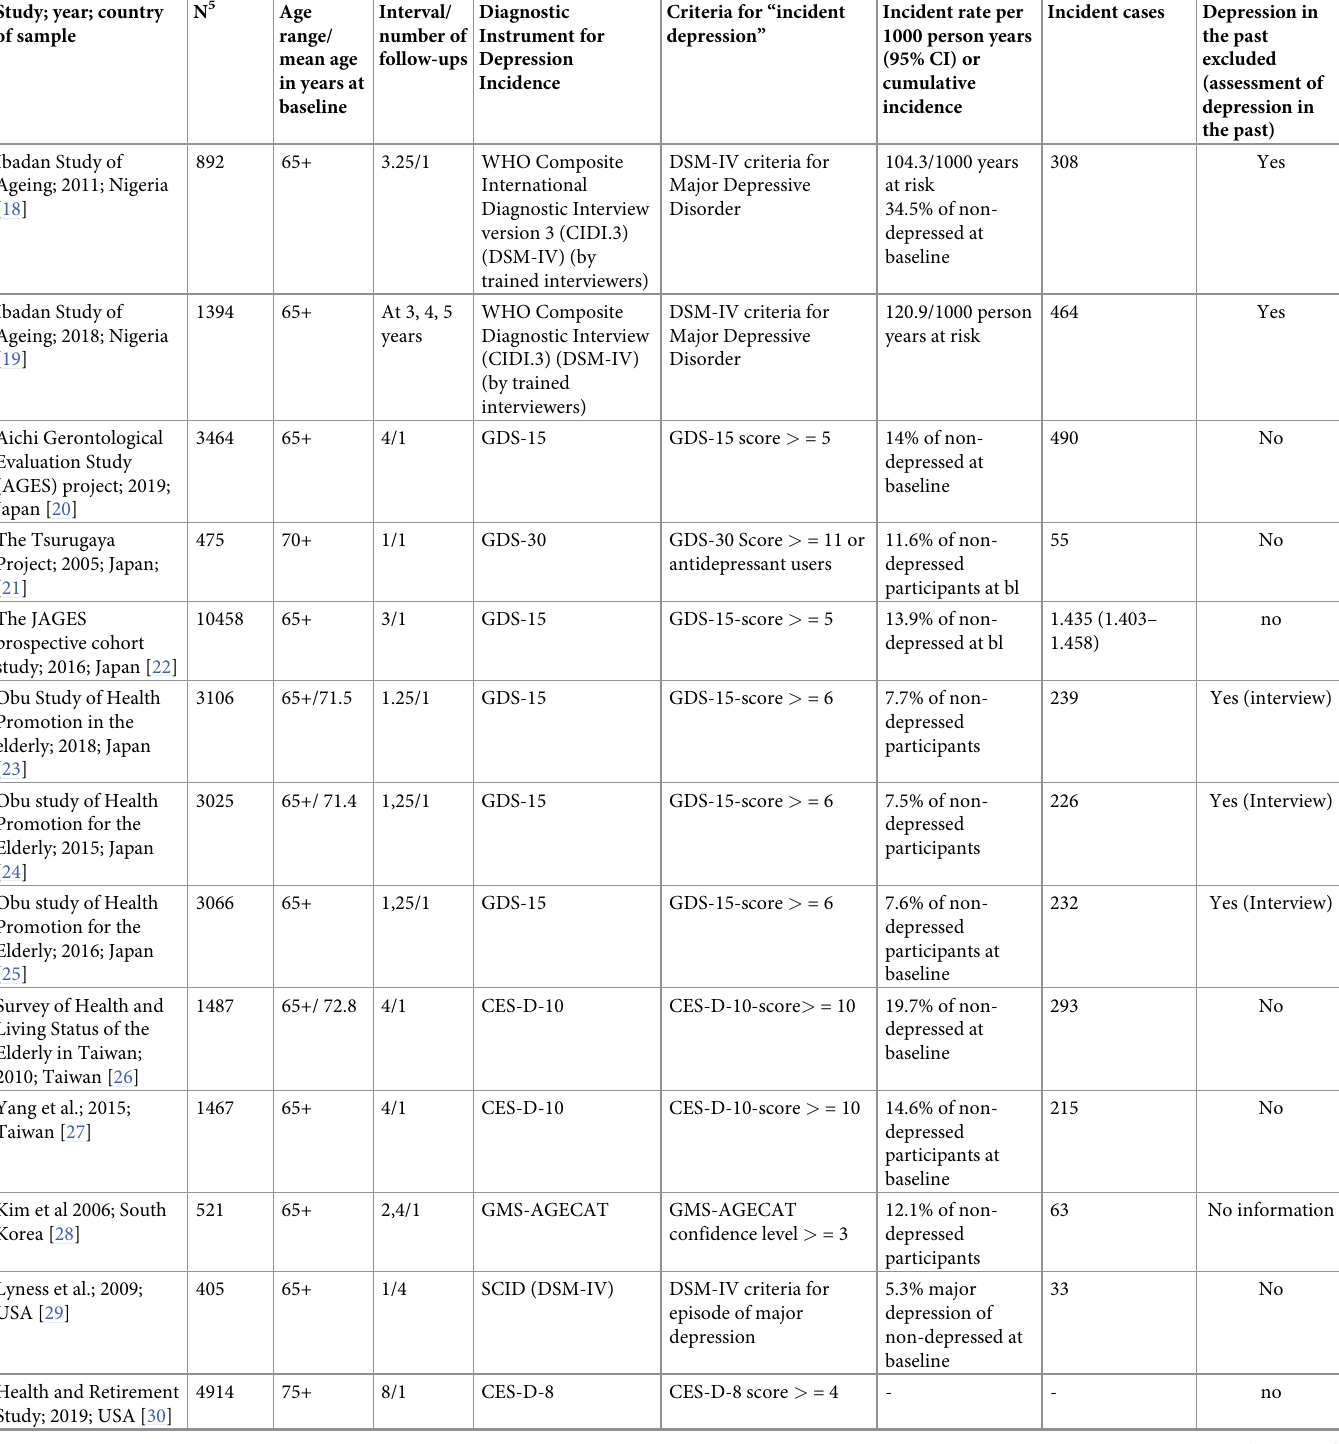
Table 2. Characteristics of included